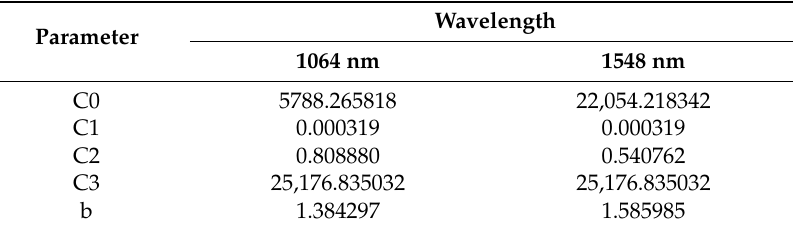
Table 3. An example set of DWEL calibration parameters.